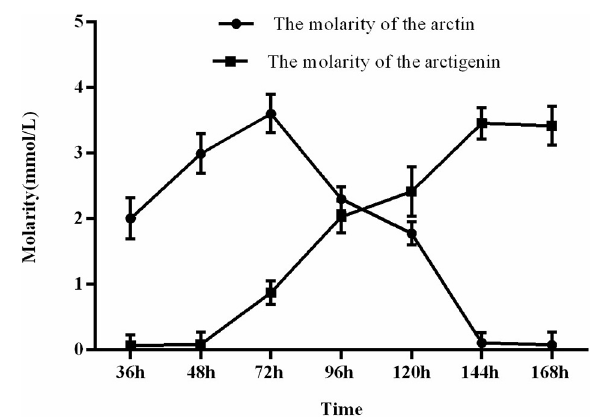
FIGURE 4 | Concentration of arctiin and arctigenin over time during the fermentation